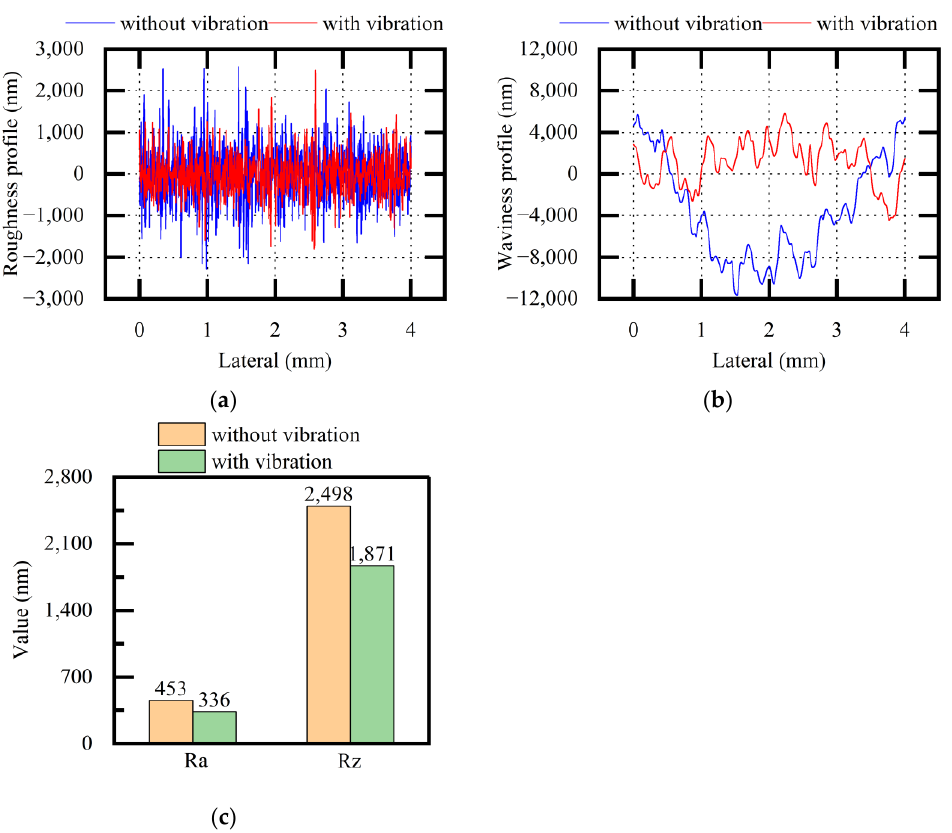
Figure 12. Comparative analysis of surface quality (HT250, variable f ): ( a ) roughness profile; ( b ) waviness profile; ( c ) average values of Ra and